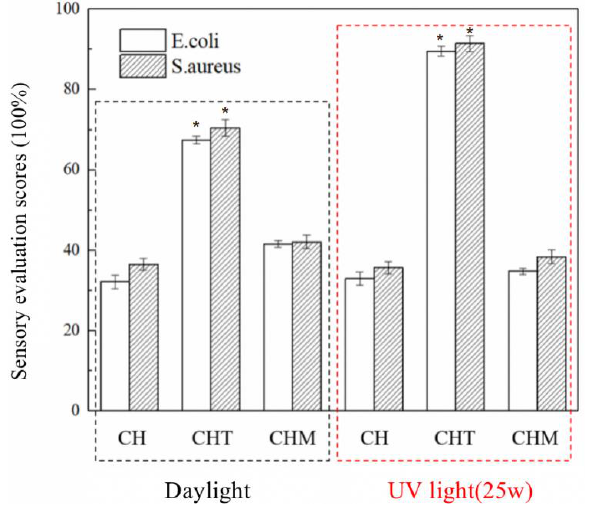
Figure 3. The broad-spectrum bacteriostatic rates of CH, CHT, and CHM under different light treatments. The symbol of “*” indicates that the data are significantly different ( p <